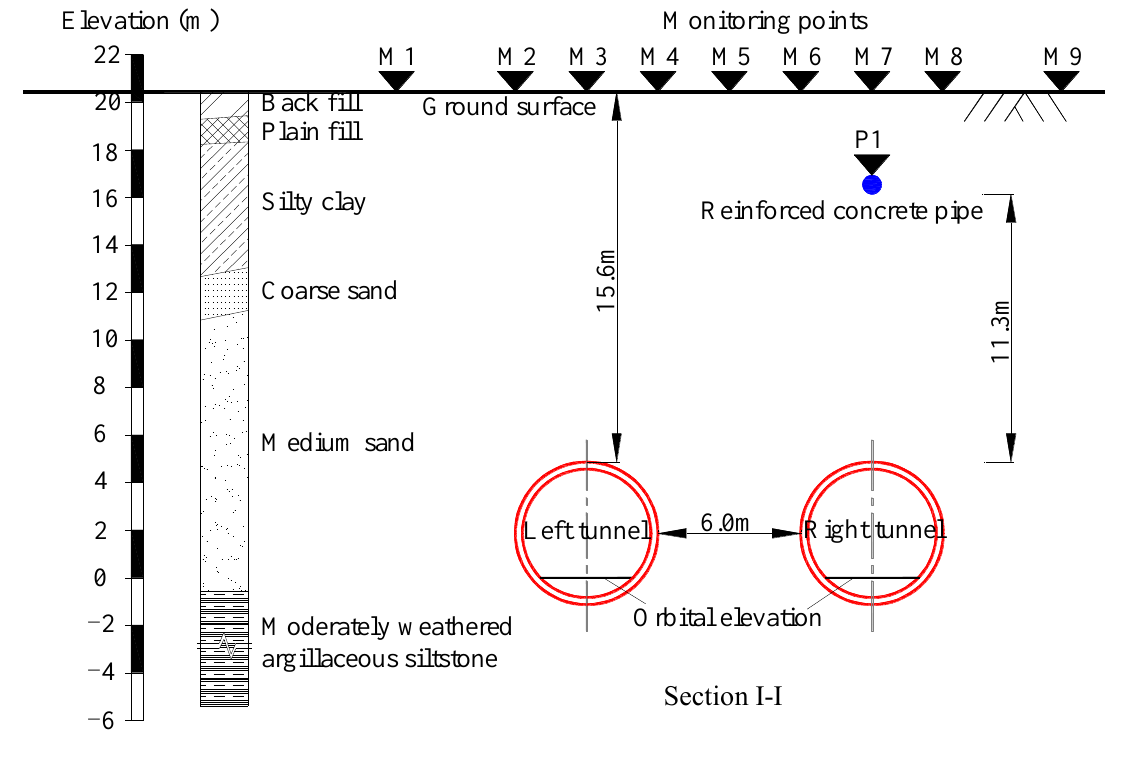
Figure 7. Monitoring section Ⅰ-Ⅰ.